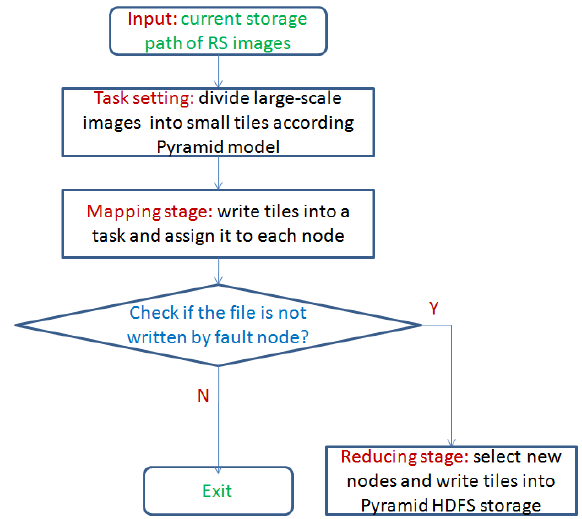
Figure 1. Storage flow of remote sensing (RS) images